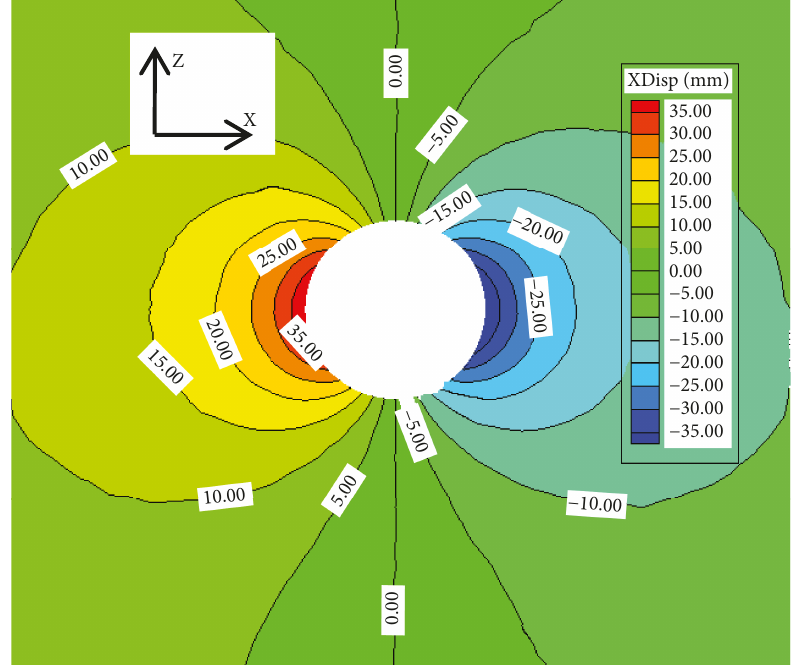
Figure 26: Displacement of section D-D along X.